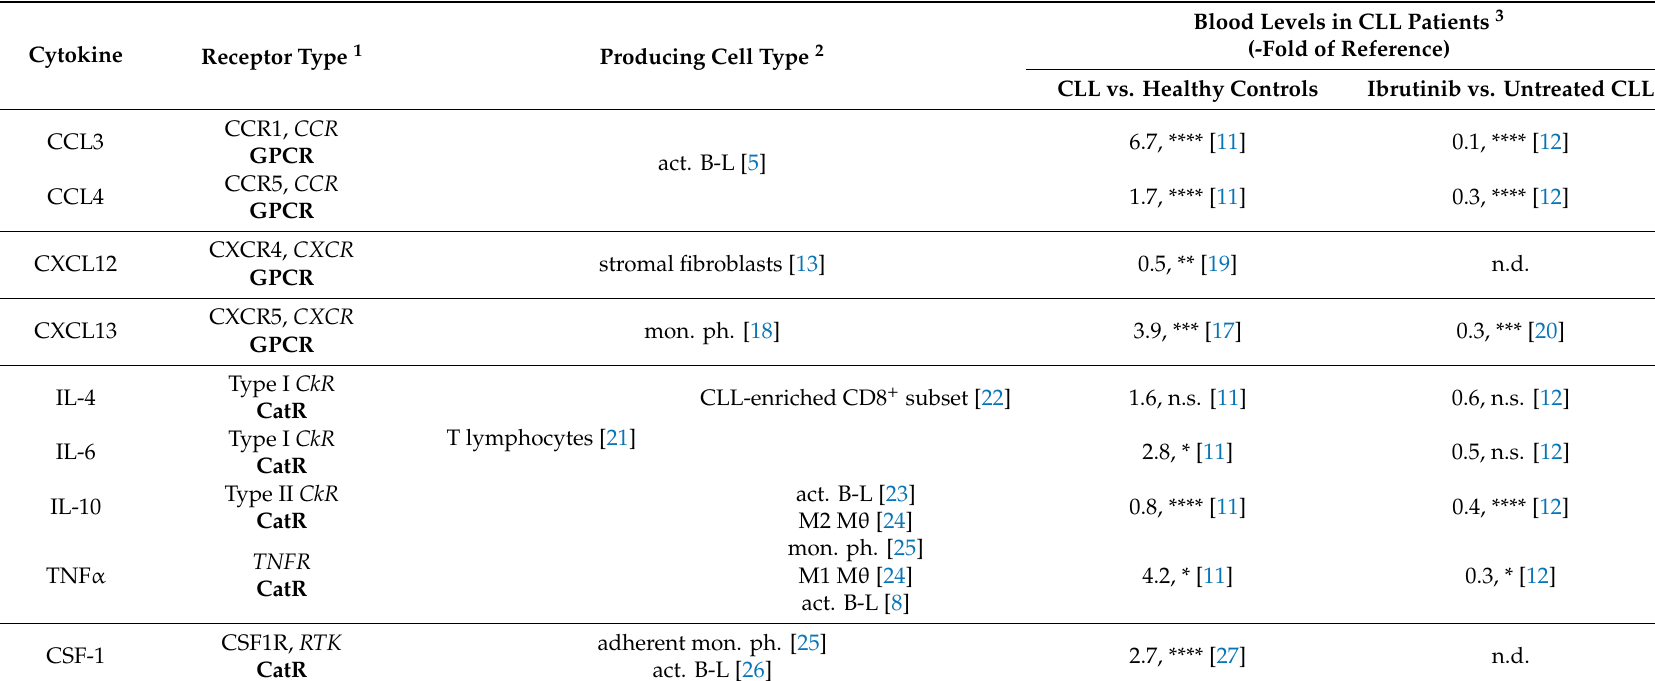
Table 1. Selected cytokines of the B cell lymphoma micro-environment and alterations of their plasma